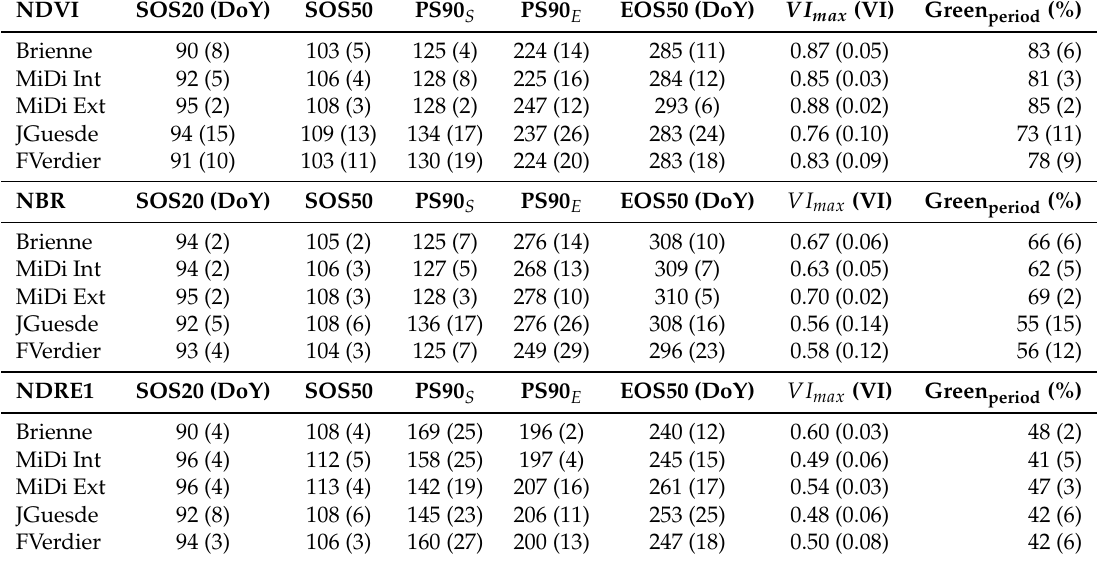
Table 4. Mean of the annual phenological dynamics criteria on D-L fitted phenological curves for NDVI, NBR and NDRE1 and for the five studied areas. Standard deviations are indicated within